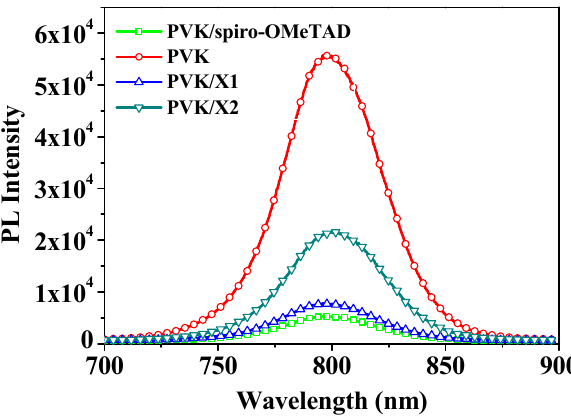
Figure 5. The steady-state PL spectra of perovskite with and without HTMs.